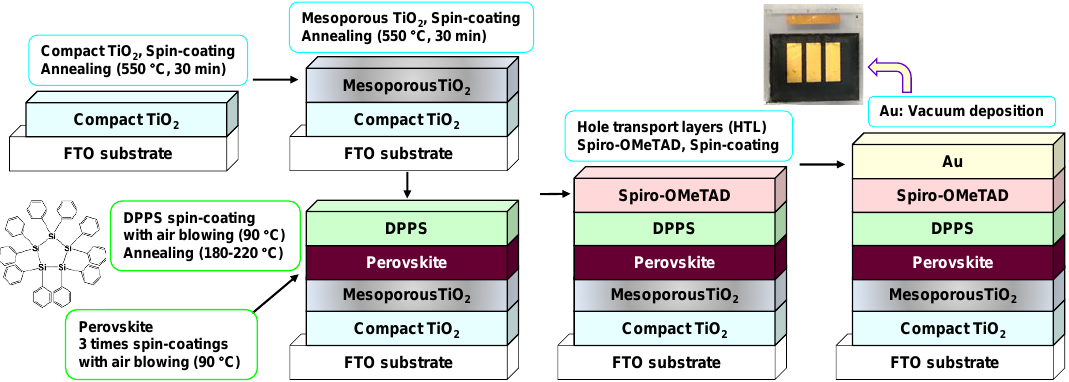
Figure 1. Schematic illustration detailing the processes adopted to fabricate the perovskite photovoltaic devices and a photograph of the device.